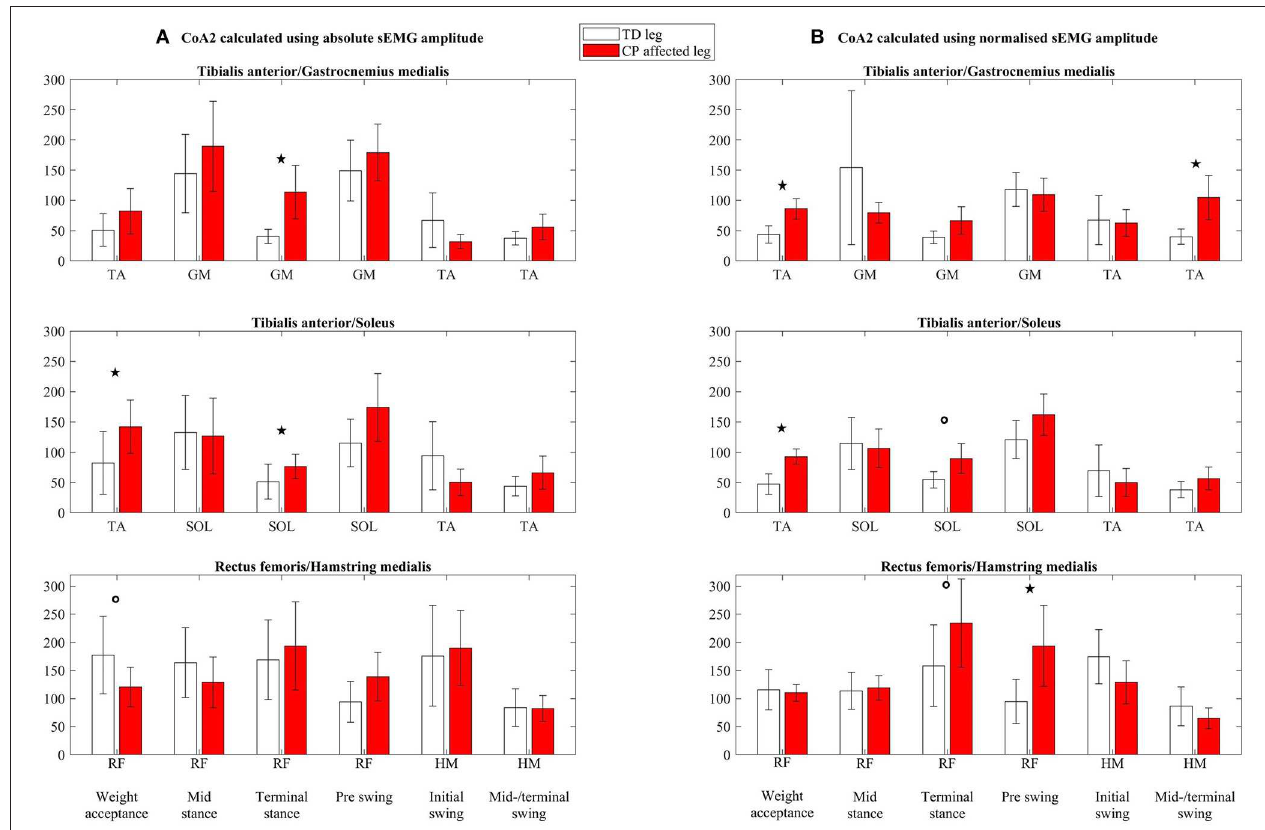
FIGURE 5 | Coactivation index 2 (CoA2) calculated using (A) absolute sEMG-RMS amplitudes (CoA2-abs) and (B) using normalized sEMG-RMS amplitudes (CoA2-norm), presented as mean with 95% confidence interval. Calculated for three coactivation muscle pairs: tibialis anterior/gastrocnemius medialis, tibialis anterior/soleus, and rectus femoris/hamstring medialis, for each of the six gait phases (named in the bottom line). The agonist in the coactivation index muscle pair is indicated for each gait phase below each subplot. TA, tibialis anterior; GM, gastrocnemius medialis; SOL, soleus; RF, rectus femoris; HM, hamstring medialis. *Significant group differences ( p < 0.05), ◦ p <